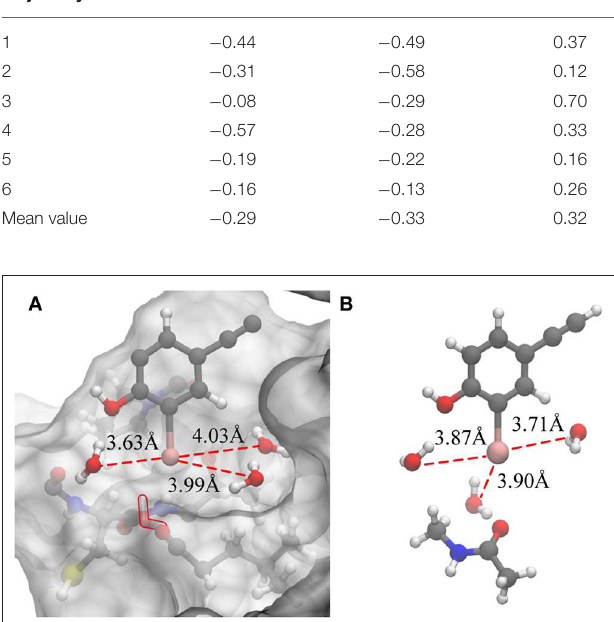
TABLE 3 | Cross-correlation coefficients between two pairs of three hydrogen bond lengths in six trajectories. Trajectory ID w1 and w2